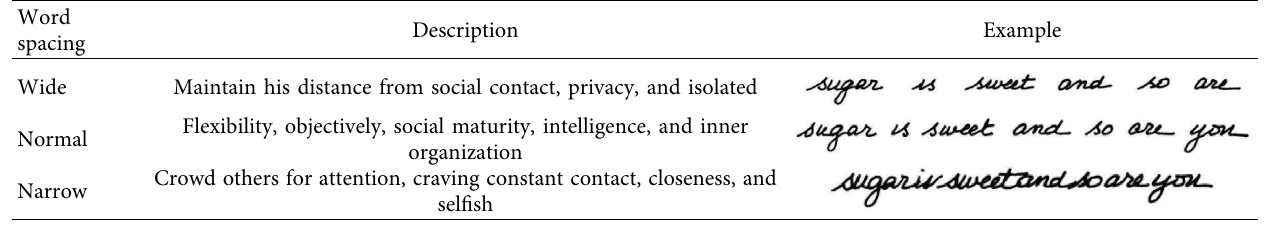
Table 5: Te word spacing features and their corresponding types.